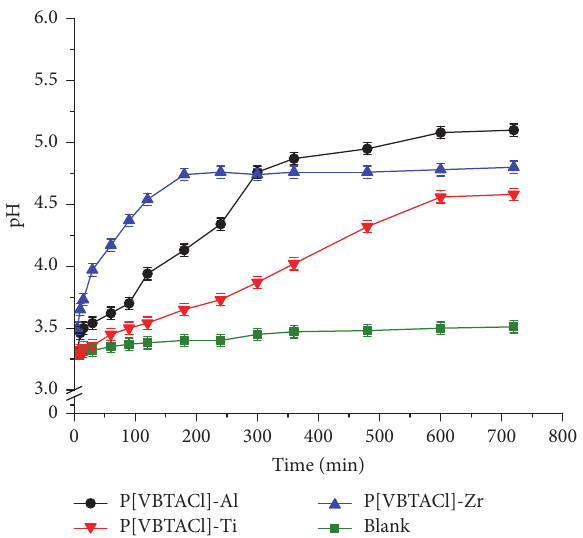
Figure 1: pH versus time for P[VBTACl]/M catalyst synthesis. Conditions: gold (III) chloride hydrate precursor concentration 6.02 × 10 −4 molL −1 . Temperature: 298 K and magnetic agitation: 300 rpm.Theblankcorrespondstothesolutionofprecursorwithout the support.